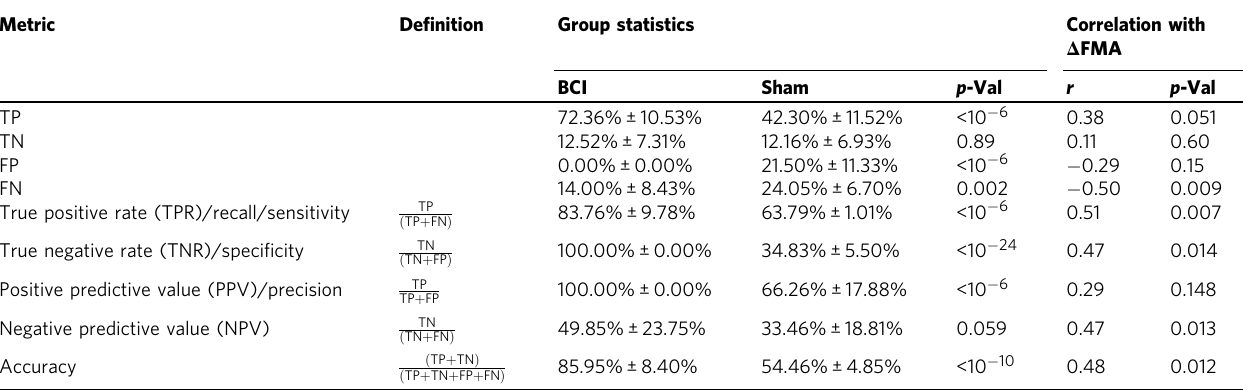
Table 3 Statistics of metrics of contingency between motor attempt decoding and FES and their correlation to motor recovery across all patients Metric De fi nition Group